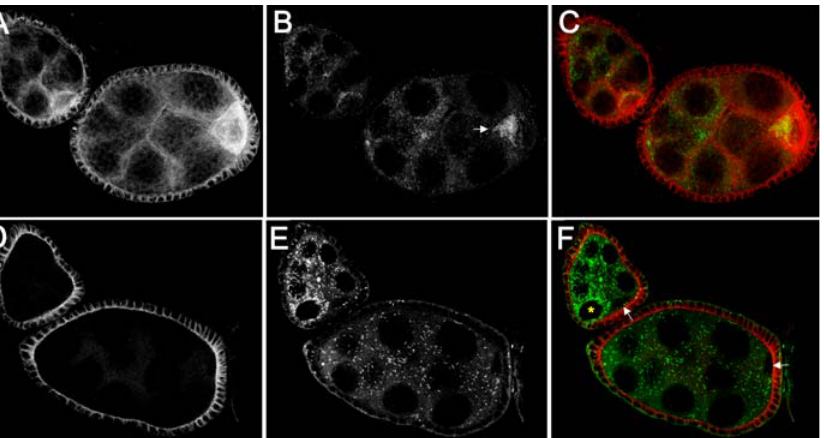
Figure 5. Depolymerization of Microtubules Causes Loss of Anterior Wolbachia Localization in the Oocyte (A–C) Stage 5 and 7 infected egg chambers, untreated. (A) Microtubules (greyscale). (B) Wolbachia (greyscale). White arrow indicates Wolbachia concentrated at the anterior region of the oocyte. (C) Merged image of (A) and (B): microtubules are red, and Wolbachia are green (hsp60). (D–F) Stage 5 and 7 infected egg chambers treated with colchicine. (D) Microtubules (greyscale). (E) Wolbachia (greyscale). (F) Merged image of (D) and (E): microtubules are red, and Wolbachia are green (hsp60). White arrows indicate positions of the oocytes. Yellow asterisk indicates a nurse cell adjacent to the oocyte in which Wolbachia appear abnormally high. DOI: 10.1371/ journal.ppat.0010014.g005